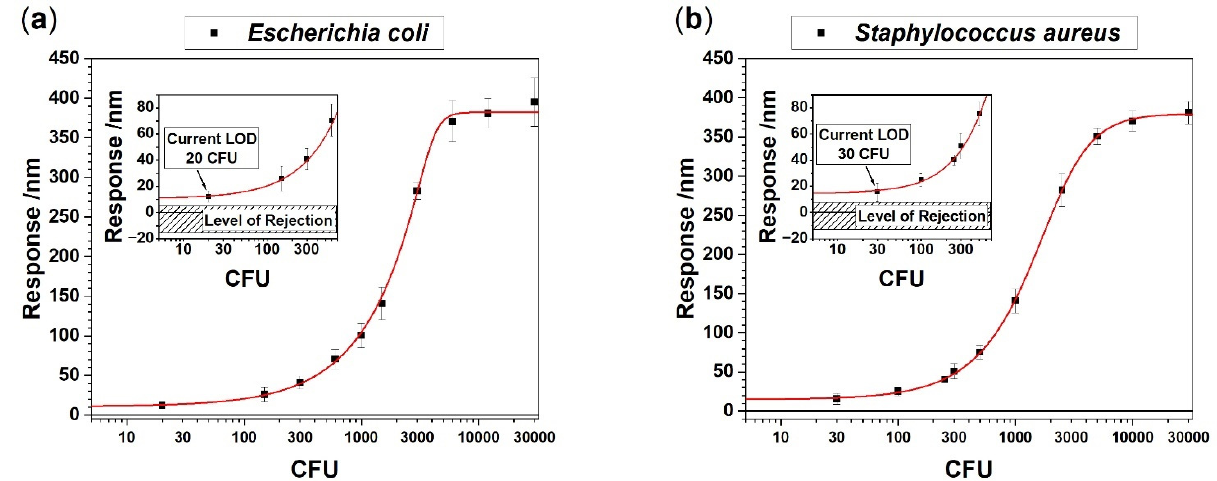
Figure 4. Evaluation of current limit of detection (LOD) in colony forming units (CFU) as measured for total RNA extracted from EDTA whole blood spiked with E. coli ( a ) or S. aureus ( b ). Each point is the average of 3 measurements. The insets show the LOD measured for E. coli as 20 CFU and for S. aureus as 30 CFU, respectively. The fitted curves using a logistic Equation (1) indicate a lower LOD of less than 5 CFU. Below that level the LOR will prevent proper analysis.